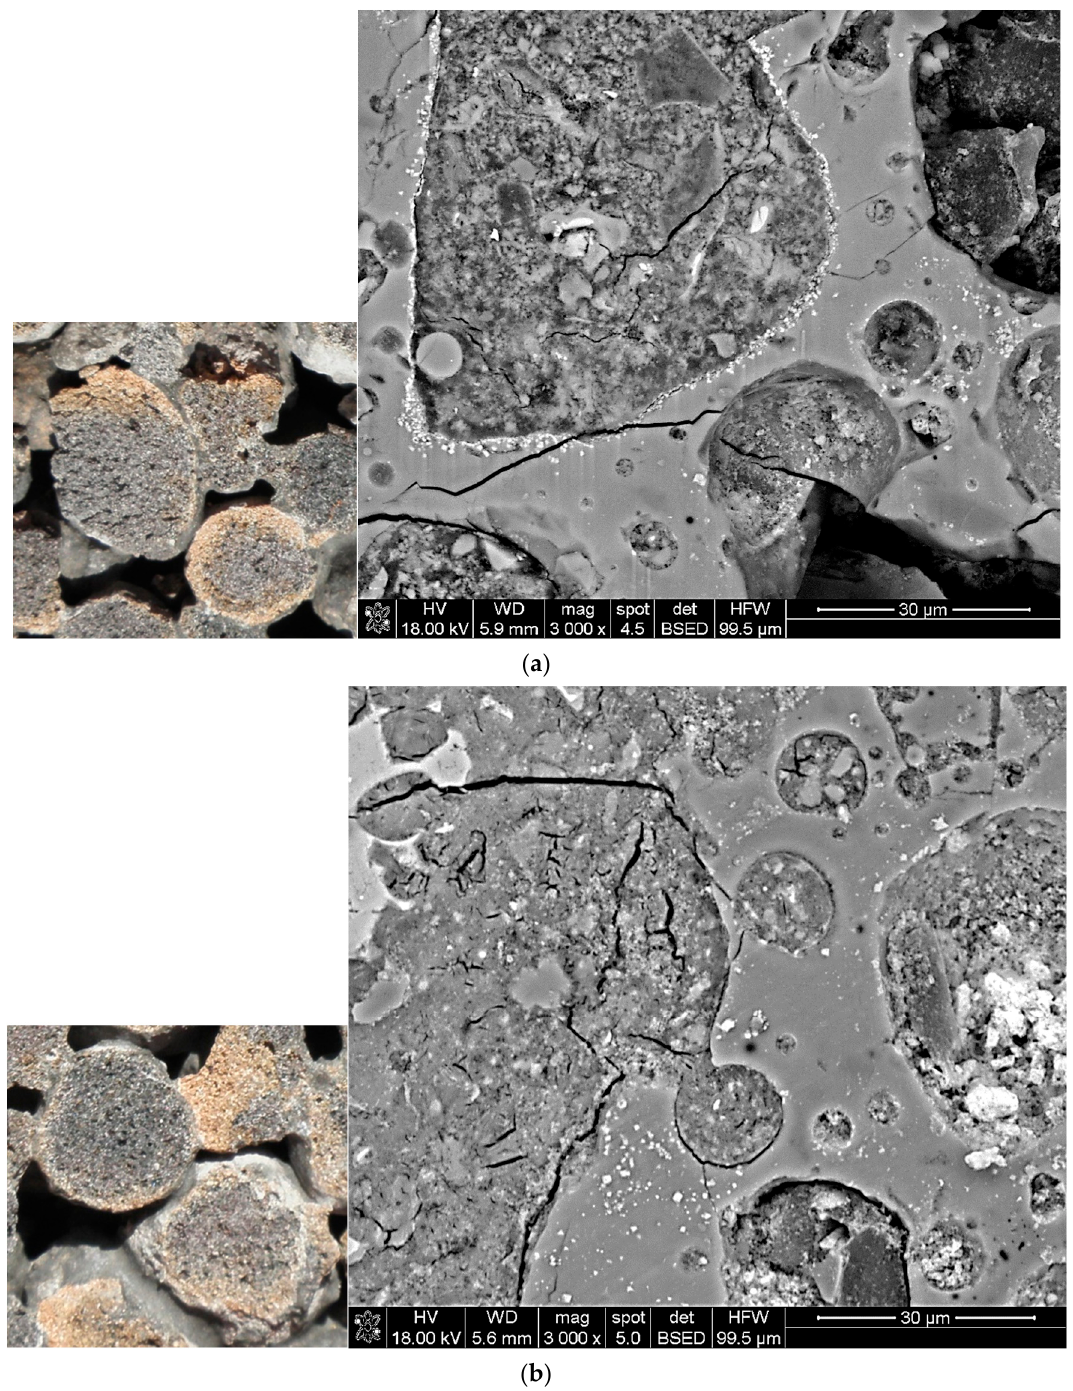
Figure 4. Cross-sections of coated particles of Lytag 6/12 mm and their shell pores filled with cement paste: ( a ) LWA initially moistened, ( b ) LWA initially dried out.